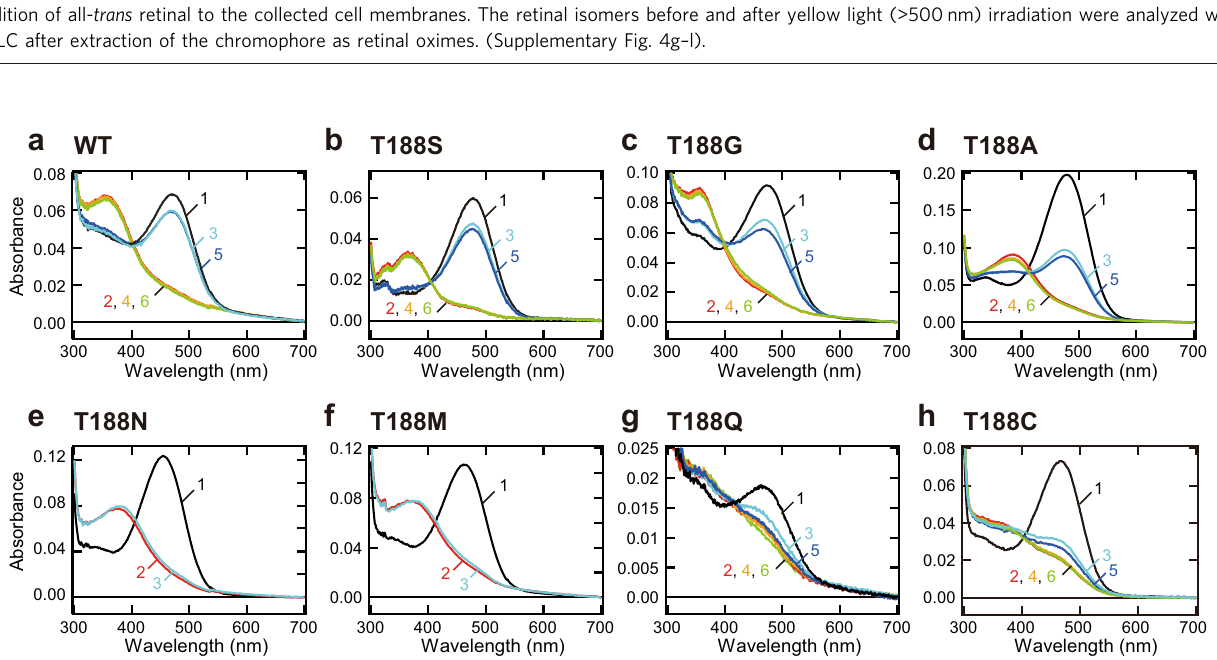
Fig. 2 Binding selectivity of retinal isomers in Opn5m Thr188 mutant proteins. a – f (left) Absorption spectra of Opn5m T188S ( a ), T188G ( b ), T188A ( c ), T188N ( d ), T188M ( e ), and T188Q ( f ) mutant proteins puri fi ed after the addition of 11- cis retinal to the collected cell membranes. The spectra were recorded at 0 °C in the dark (curve 1) and after yellow light irradiation (curve 2). Spectral change by light irradiation is shown in Supplementary Fig. 3. (right) Retinal con fi guration changes of Opn5m T188S ( a ), T188G ( b ), T188A ( c ), T188N ( d ), T188M ( e ), and T188Q ( f ) mutant proteins puri fi ed after the addition of 11- cis retinal to the collected cell membranes. The retinal isomers before and after yellow light (>500 nm) irradiation were analyzed with HPLC after extraction of the chromophore as retinal oximes. (Supplementary Fig. 4a – f). g – l (left) Absorption spectra of Opn5m T188S ( g ), T188G ( h ), T188A ( i ), T188N ( j ), T188M ( k ), and T188Q ( l ) mutant proteins puri fi ed after the addition of all- trans retinal to the collected cell membranes. The spectra were recorded at 0 °C in the dark (curve 1) and after yellow light irradiation (curve 2). Spectral change by light irradiation is shown in Supplementary Fig. 3. (right) Retinal con fi guration changes of Opn5m T188S ( g ), T188G ( h ) T188A ( i ), T188N ( j ), T188M ( k ), and T188Q ( l ) mutant proteins puri fi ed after the